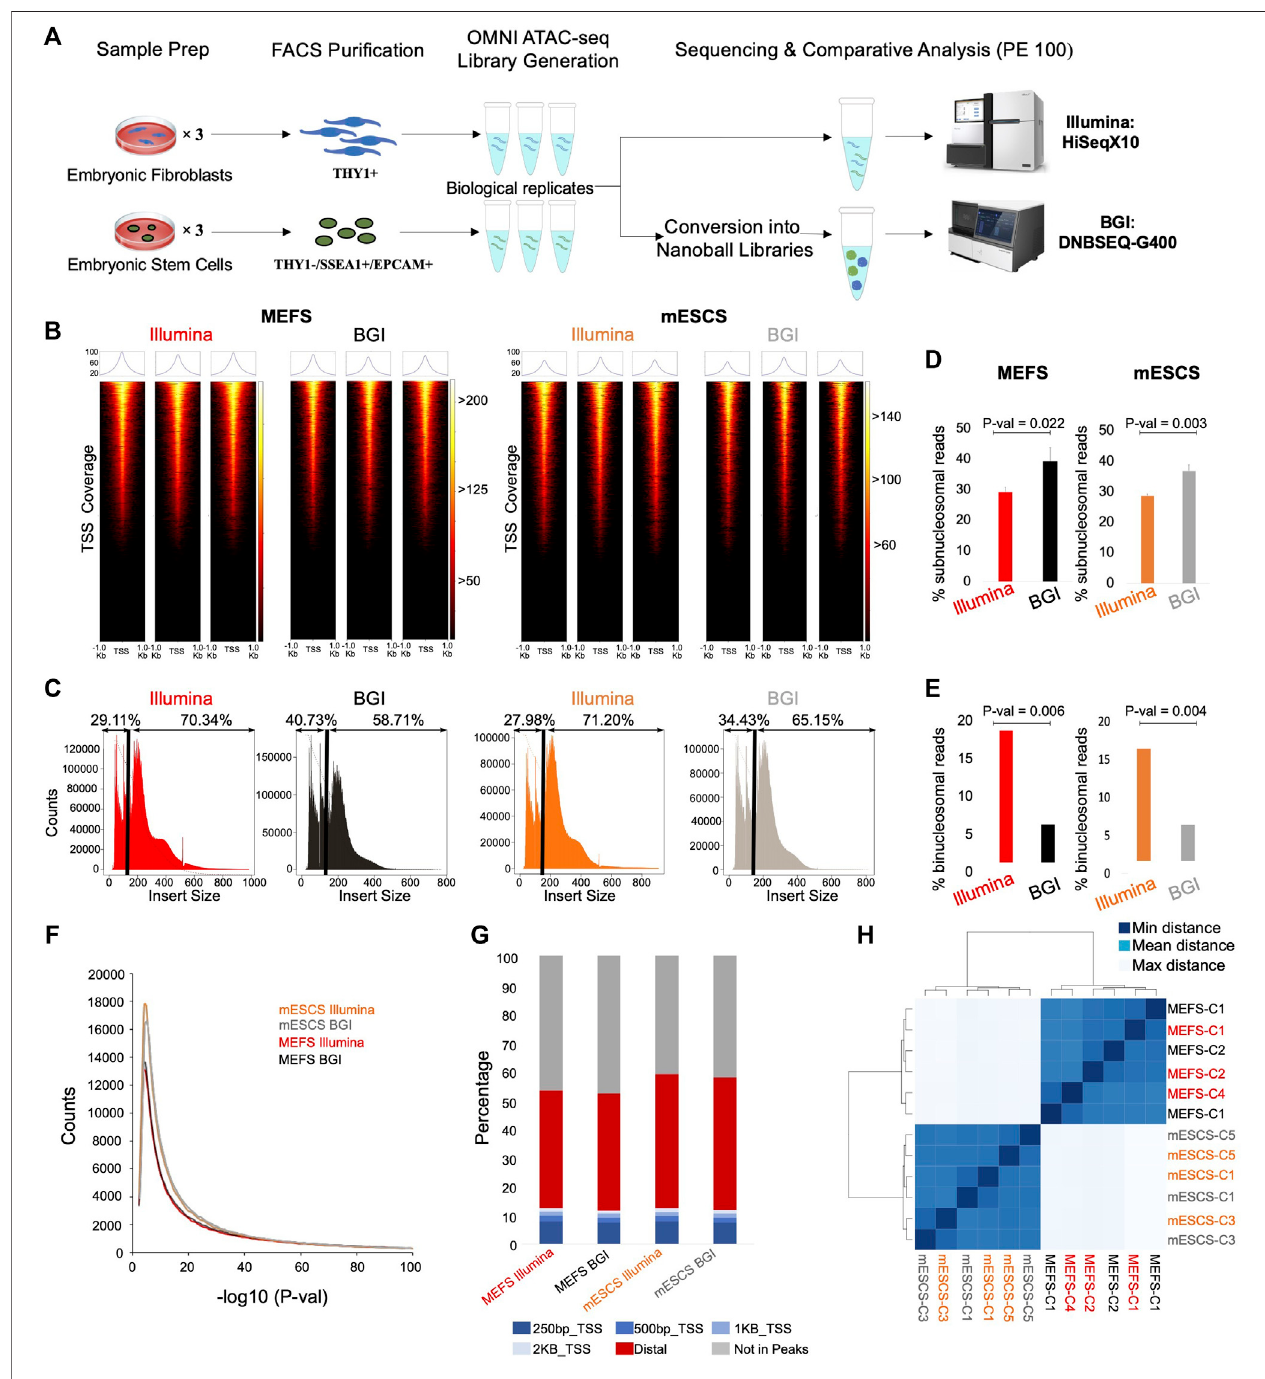
FIGURE 1 | Genomic context and insert size distribution of sequenced reads. (A) Schematic overview of experimental setup (e.g., Omni-ATACseq library generationfromthreebiologicalreplicatesamplesforMEFsandmESCseach). (B) Enrichmentofsequencingfragmentsattranscriptionalstartsites(TSS,±1 Kb)fordata from both platforms ( n = 3, biological replicates). The color scale indicates the number of reads mapping to each TSS across the genome. (C) Representative plots depicting insert size distribution for data from the different sequencing platforms; a black line indicates the boundary between sub- and mono/poly-nucleosomal readswithrelative%valuesindicatedabove. (D) Quanti fi cationofpercentage ofbi-nucleosomalreadsinIlluminaversusBGIdataforMEFsandmESCs( n =3,biological replicates,Student ’ s t -test,two-tailed,unpaired). (E) Quanti fi cationofthepercentageofsub-nucleosomalreadsinIlluminaversusBGIdataforMEFsand mESCs( n =3, biological replicates, Student ’ s t -test, two-tailed, unpaired). (F) Peak calling was performed (MACS2), followed by visualization of peak numbers (averaged across the three biological replicates) with their associated p -values. (G) Genomic context of reads from each sample group (averaged across the three biological replicates). (H) UnsupervisedclusteringofallsamplesbasedonEuclideandistanceonthenumberofcountswithinopen-regions( n =3biologicalreplicates)minimaldistance=0,mean distance = 315, and maximal distance = 540.